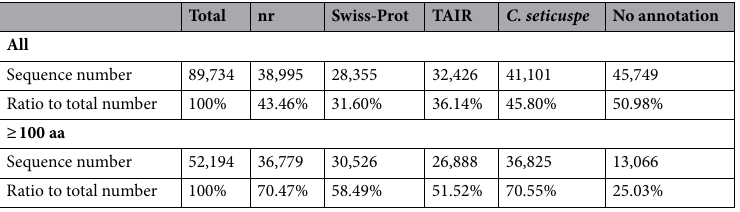
Ratio to total sequence number